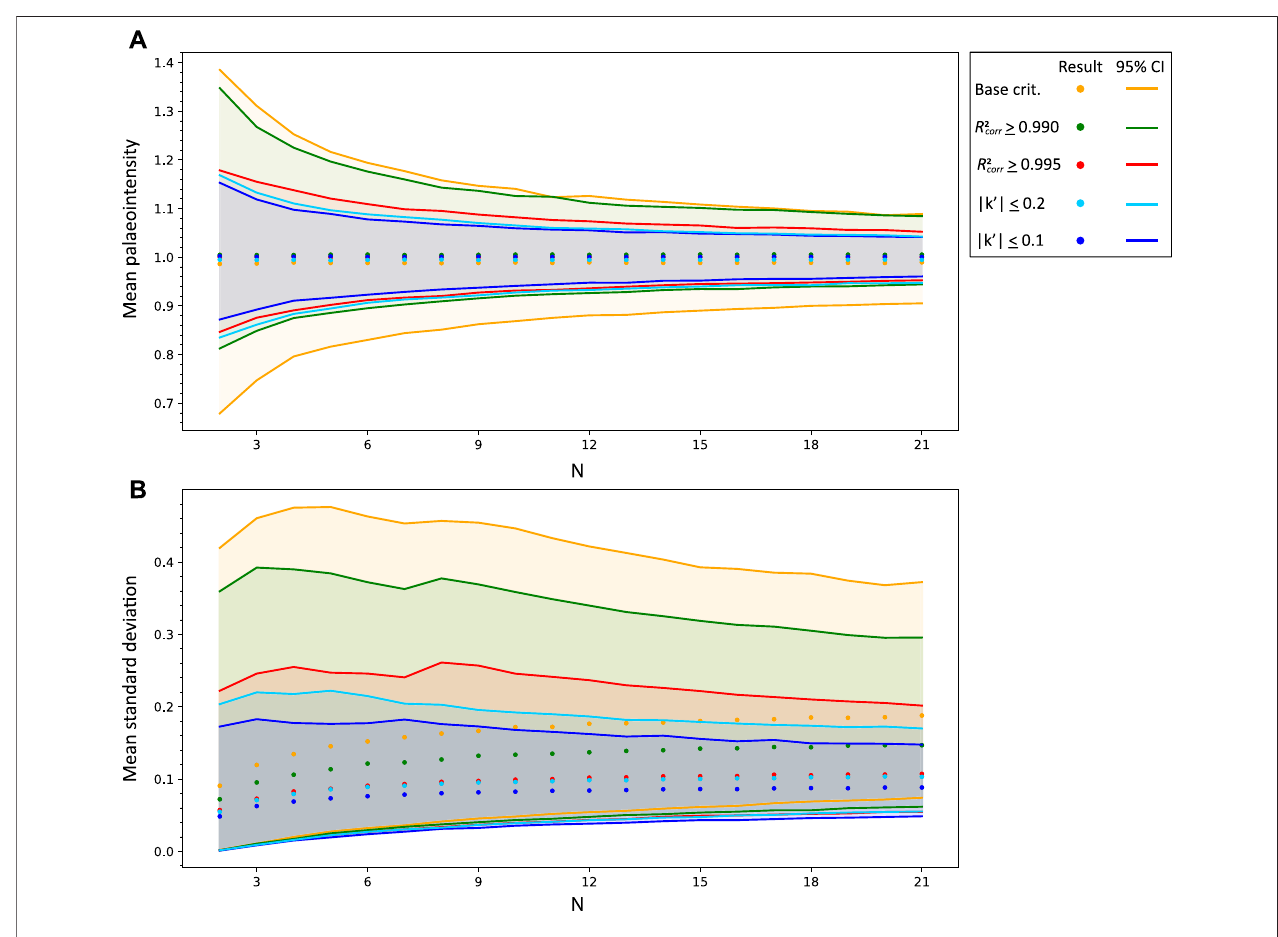
FIGURE 3 | Plots ofthedownsampledresultswithincreasingN,shownuptoN (cid:1) 21. (A) Meanpalaeointensity(dots)arethe(N)meanoftenthousandrandomlysampled specimens,andassociated95%con fi denceinterval(solidlines)resultsafterapplyingeachsetofthetestedselectioncriteria. (B) Meanstandarddeviation(dots)isthe(N)meanof ten thousand randomly sampled specimens and associated 95% con fi dence interval (solid lines) results after applying each set of the tested selection criteria.